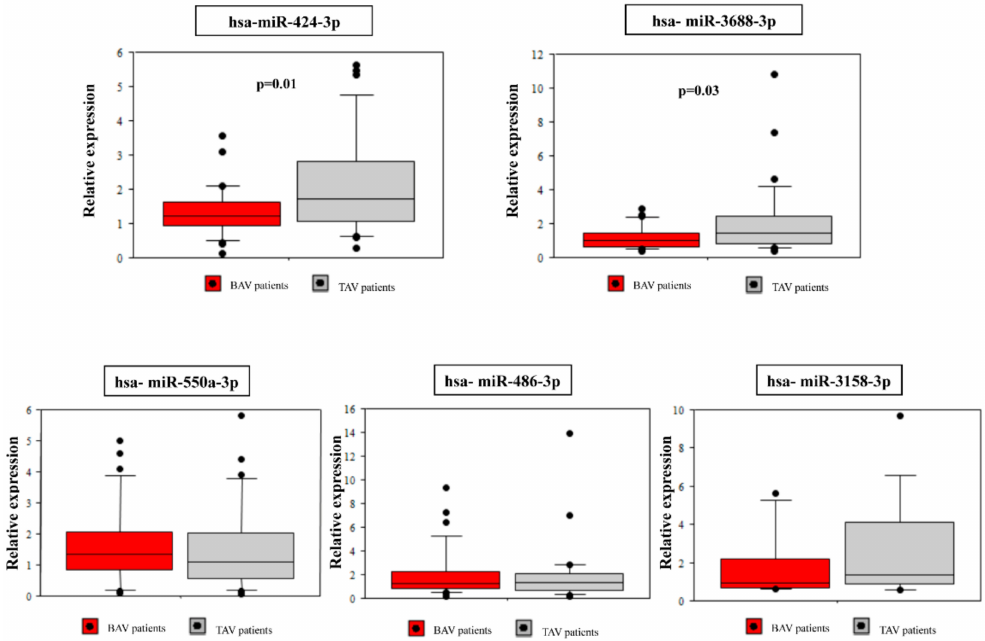
Figure 3. qRT-PCR validation of selected differentially expressed miRNAs in BAV and TAV